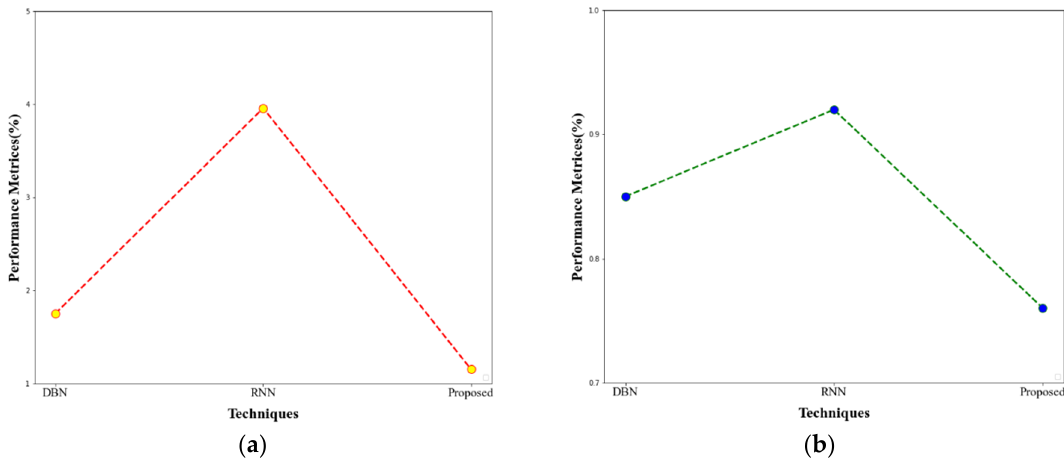
Figure 10. ( a ) FPR comparison for CICIDS-2017 dataset ( b ) FPR comparison for UNSW-NB15 dataset.